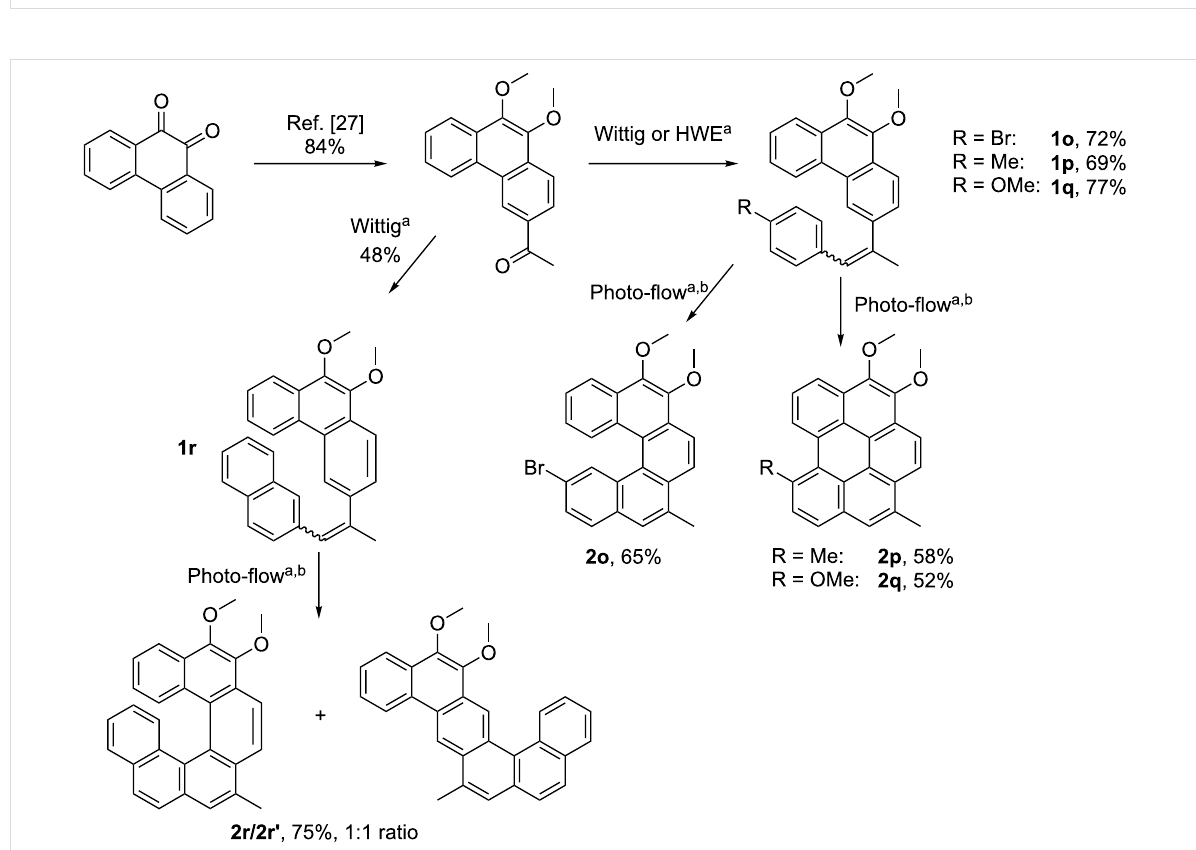
Scheme 2: Photo-flow synthesis of [5]- and [6]helicenes. a For experimental details see Supporting Information File 1. b Reaction conditions: 1.1 equiv iodine, 20 equiv THF, UV-light, 2 h retention